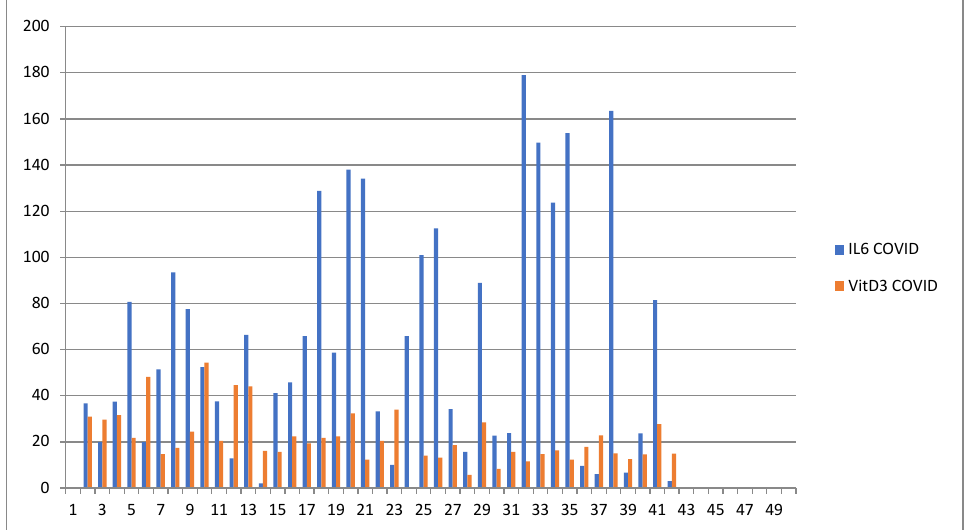
Figure 6. Graphic showing the plasma concentration of vitamin D (blue) and IL-6 (orange-red) within 48 h of hospitalization in patients with COVID-19.